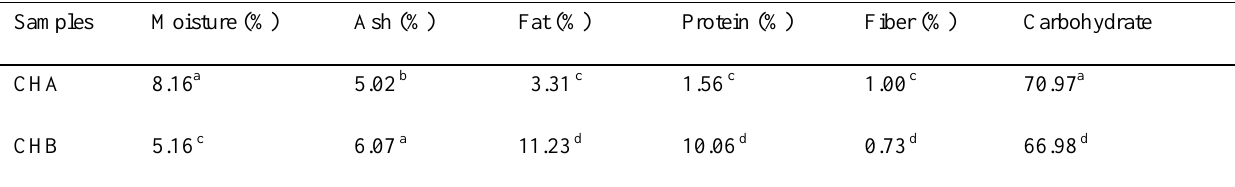
Table 2: Proximate composition of Chin-Chin samples